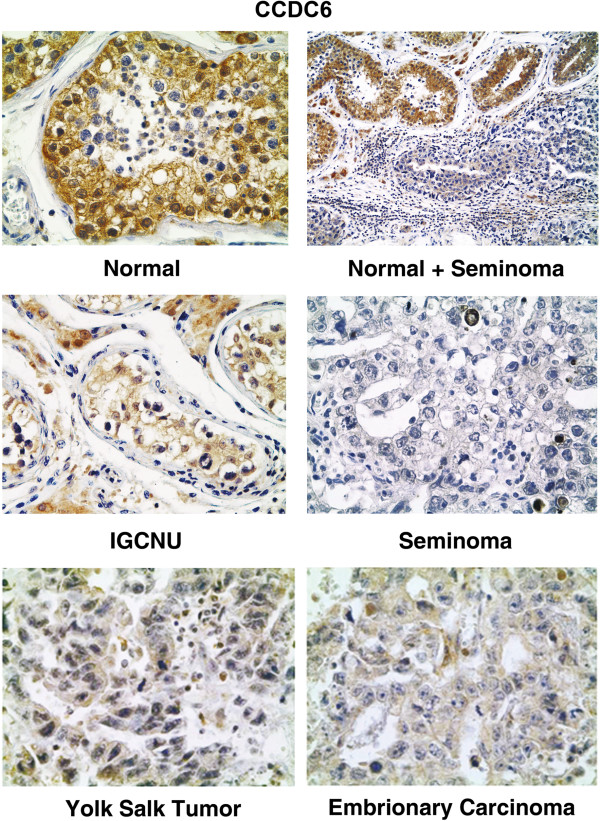
Immunohistochemical staining for CCDC6 in human testis. Immunohistochemical staining for CCDC6 in normal testis, normal testis adjacent to an area of seminoma, IGCNU (intratubular germ cell neoplasia unclassified), seminoma (top to bottom), yolk sac tumor and embyonary carcinoma. Immunoreactivity for CCDC6 is mainly detected in nuclei of primordial germinal cells and Sertoli cells of normal testis; nuclear CCDC6 reactivity is almost absent in IGCNU, in seminoma, in yolk sac tumour and in embryonal carcinoma. Magnifications are respectively: 200×, 106×, 250×, 250×, 250×, 250×.